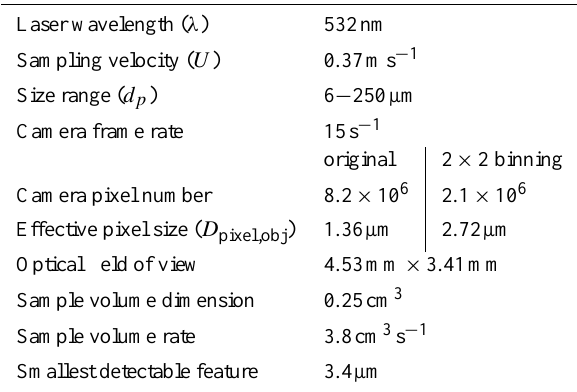
Table 1. HOLIMO II instrument